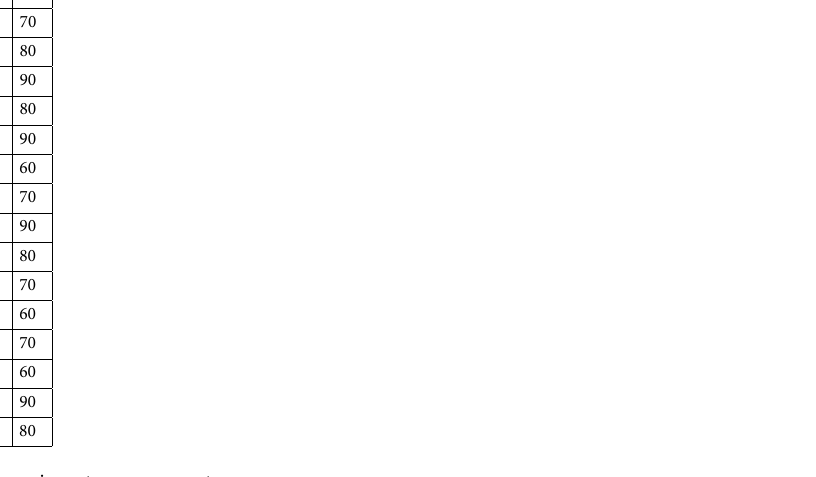
Table 4. Orthogonal experiment